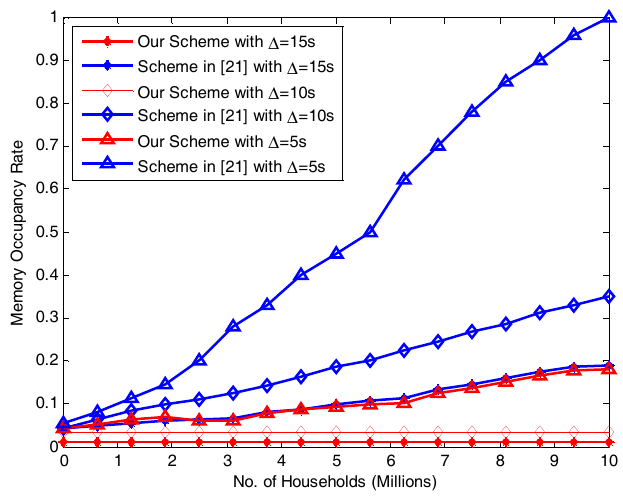
Figure 8. Comparison of memory use between our scheme and [21] with different ∆ values.